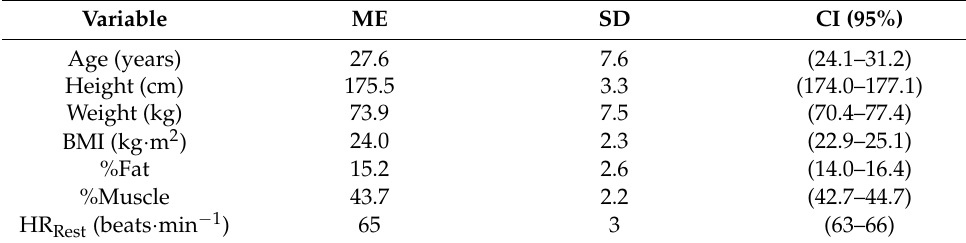
Table 1. Descriptive data on anthropometry and body